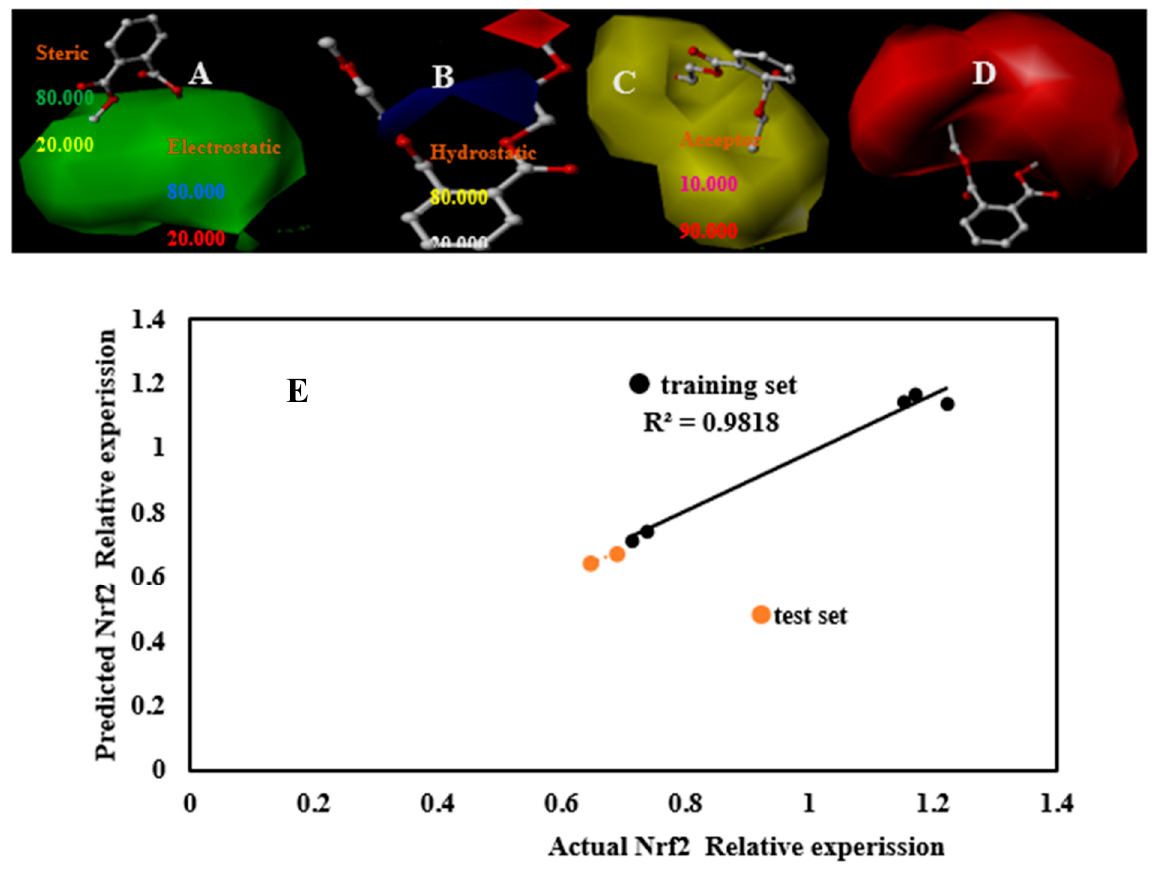
Figure 5. DMEP’s three-dimensional contour maps of steric field ( A ), the electrostatic field ( B ), hydrophobic field ( C ), Acceptor field ( D ) in the CoMSIA model. The relation schema between predicted values and experimental values on Nrf2 content ( E : CoMFA).